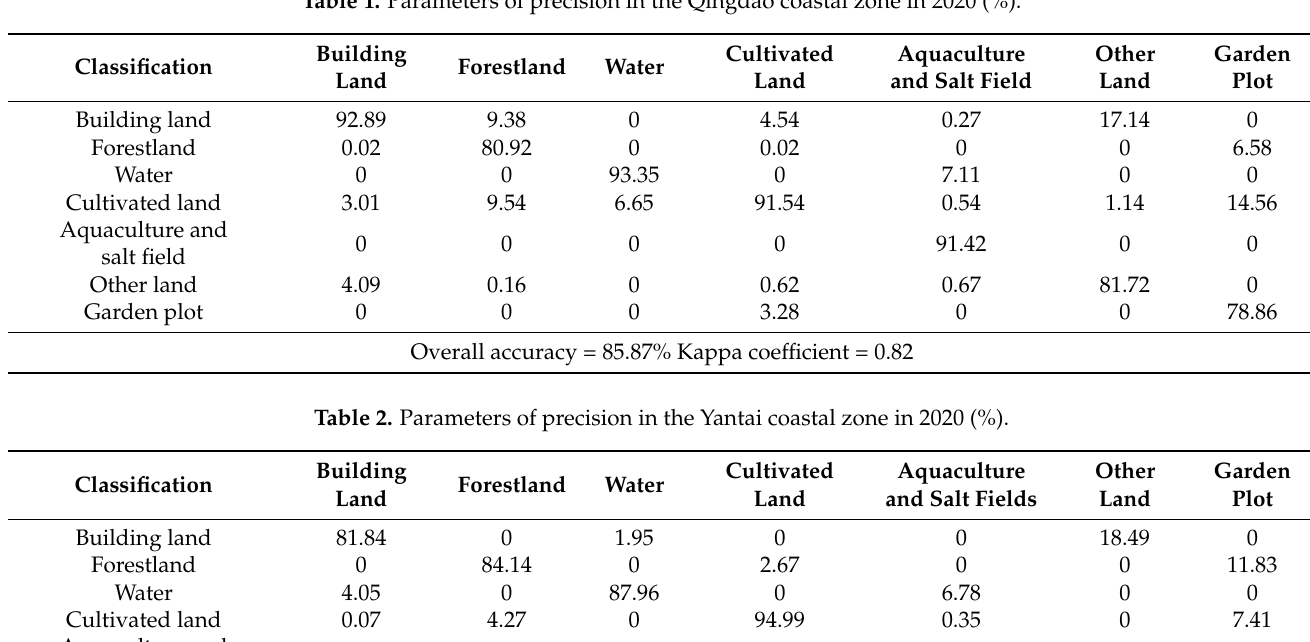
Table 1. Parameters of precision in the Qingdao coastal zone in 2020 (%).